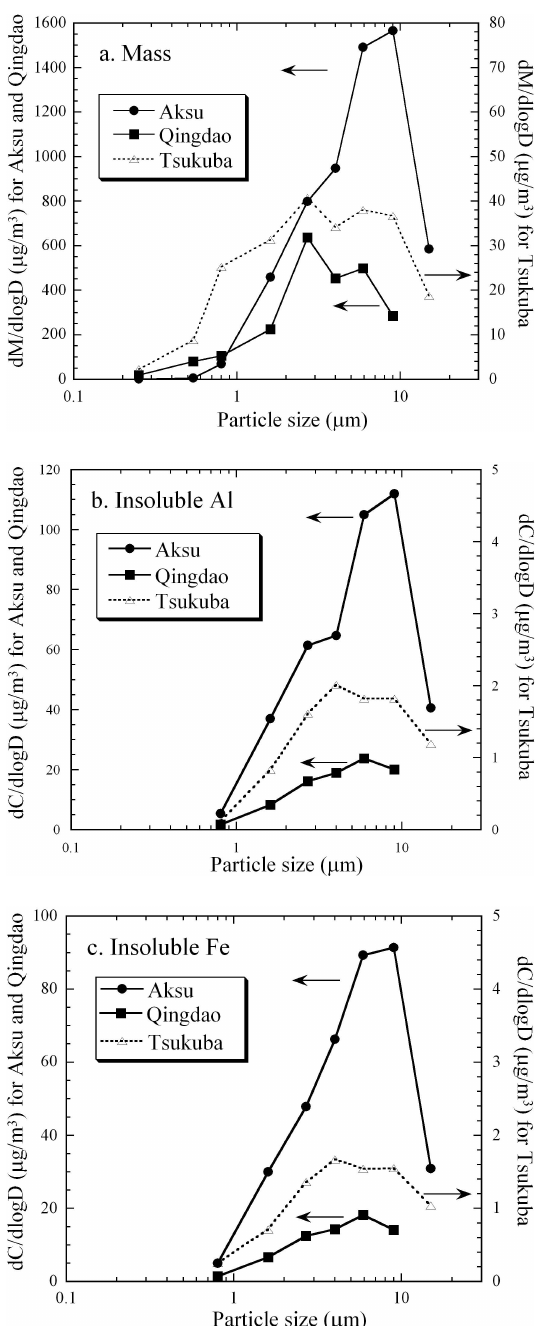
Fig. 1. Physical and chemical characteristics of aerosol samples. (a) Mass distributions of aerosols with different particle diameters. Samples were collected during the large dust event simultaneously observed in Aksu, Qingdao, and Tsukuba in March 2002. (b, c) The distributions of chemical compositions of the water-insoluble Al and Fe,